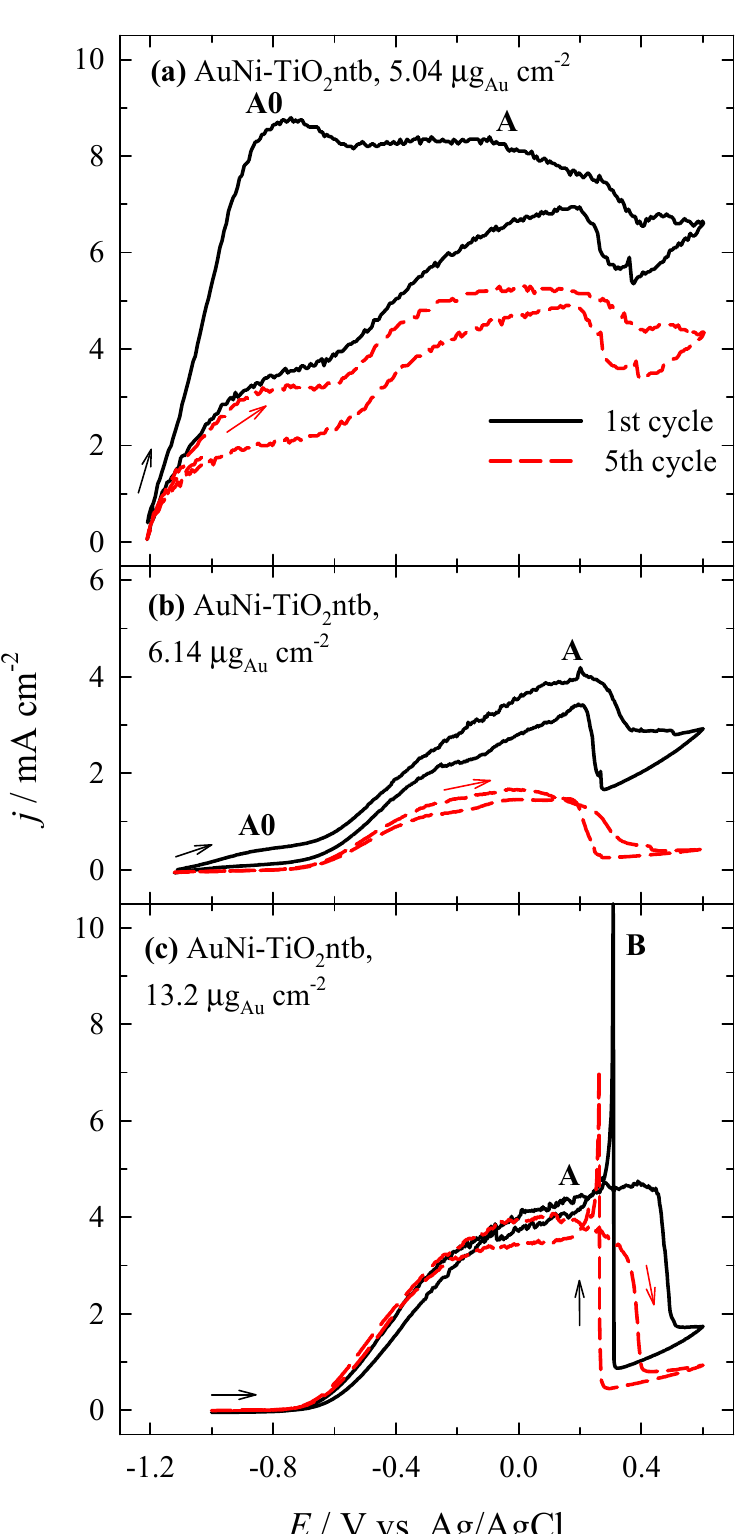
Figure 5. CVs were recorded on the different AuNi-TiO 2 ntb catalysts in a 0.05 M NaBH 4 + 1 M NaOH solution at 25 °C at 10 mV·s − 1 . AuNi-TiO 2 ntbs were fabricated by the dipping of TiO 2 ntb in the Ni plating solution operated at 85 °C for 5 s, followed by their dipping in the Au plating solution for time (s): ( a ) 60, ( b ) 300, and ( c ) 1800.